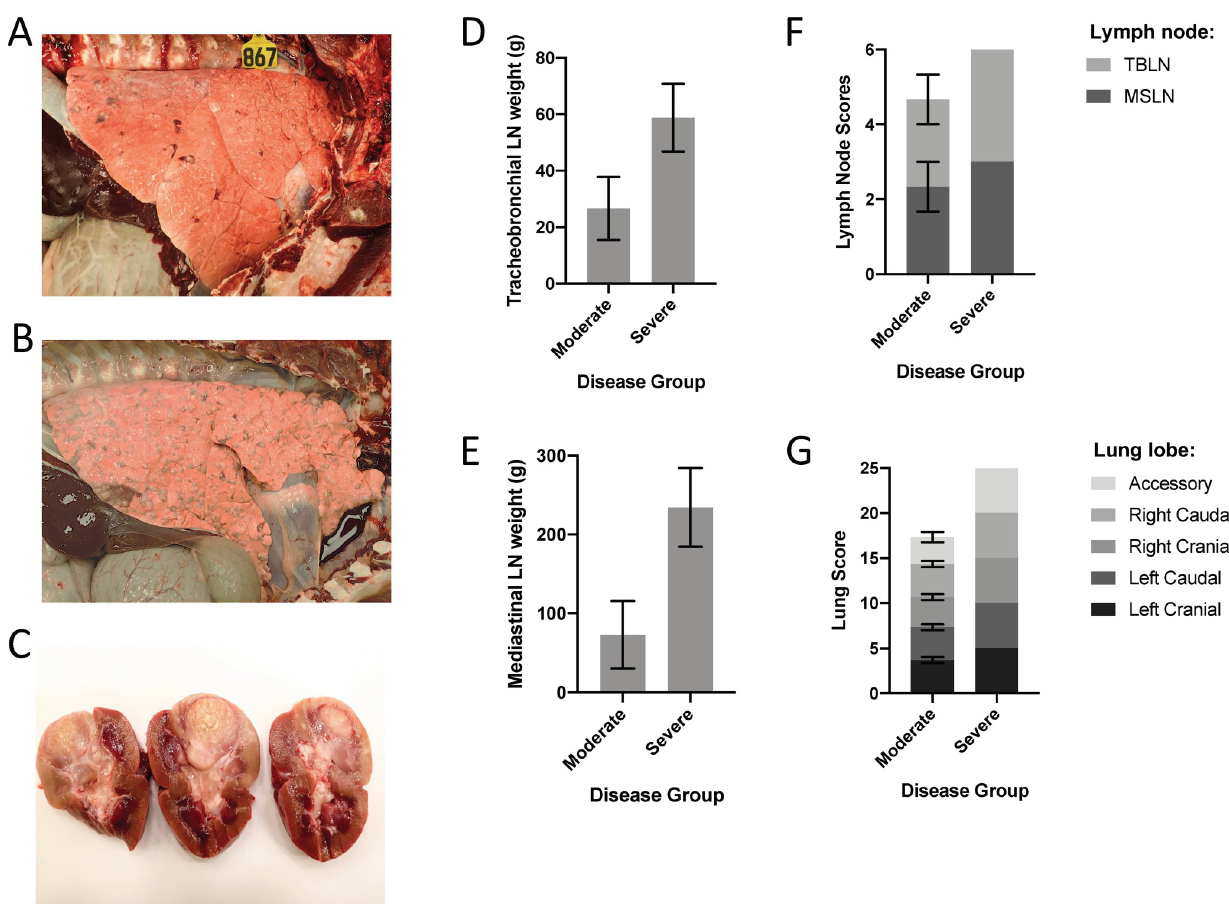
Fig 3. Cattle experimentally infected with M . bovis develop moderate or severe disease. (A-C) Gross pathology of M . bovis- infected cattle. Lung from moderately-affected (A) or severely-affected (B) calf following experimental infection. Kidney with tuberculous lesions from extrapulmonary dissemination in a severely-affected calf (C). (D-E) Weight of tracheobronchial (D) and mediastinal (E) lymph nodes from moderately-affected (n = 3) vs. severely-affected (n = 4) cattle. Black bars represent standard error of the mean. (F-G) Disease pathology scores of respiratory-associated lymph nodes (F) and lung lobes (G) in moderately- (n = 3) vs. severely-affected (n = 4) cattle. Black bars represent standard error of the mean. LN = lymph node; TBLN = tracheobronchial lymph node; MSLN = mediastinal lymph node.